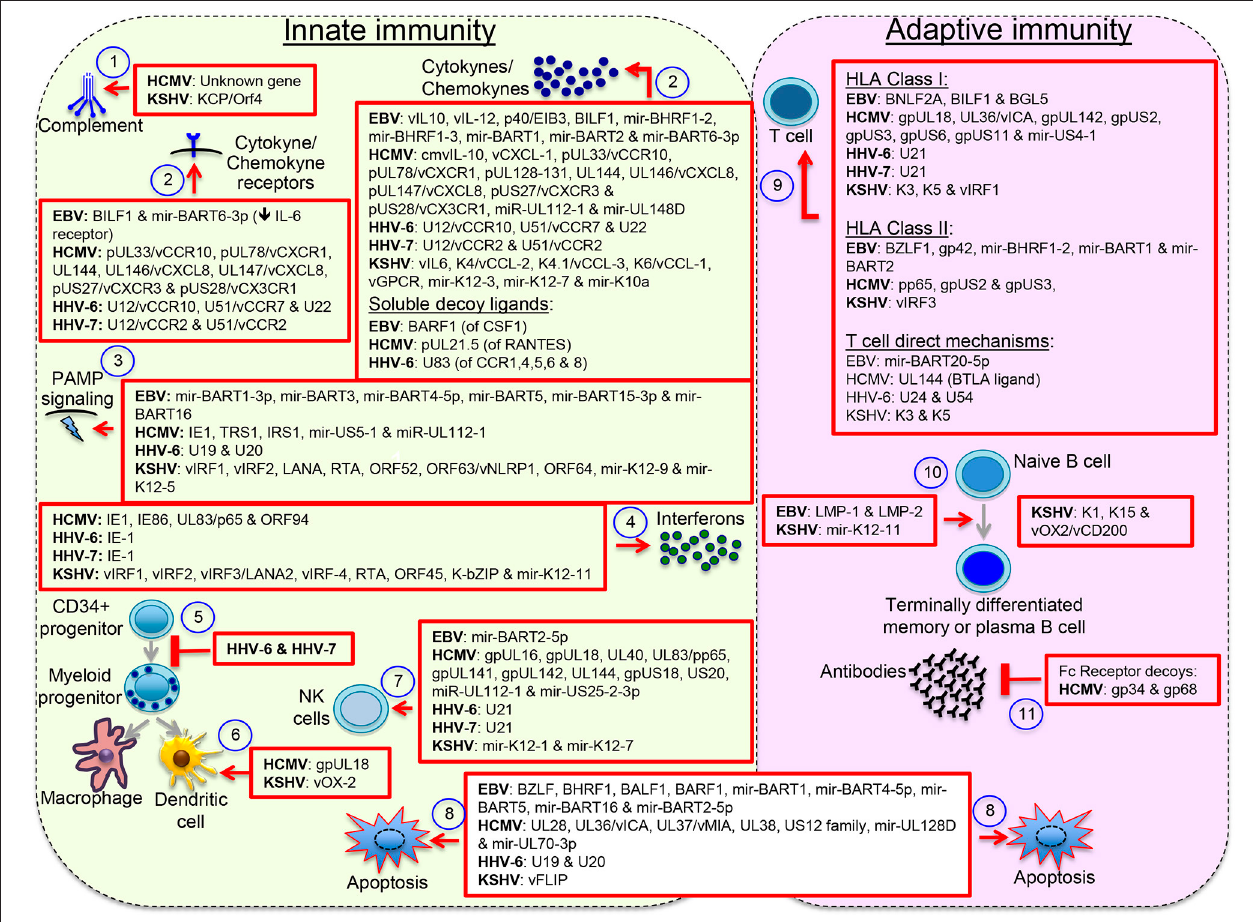
FIGURE 2 | Herpesvirus immunomodulatory mechanisms. Immunomodulatory viral genes function at multiple levels: (1) antagonizing complement, (2) interfering with host cytokines and chemokines, (3) & (4) interfering with the pathogen-associated molecular pattern (PAMP) signaling pathways that lead to interferon activation or directly with the effects of interferons, (5) inhibiting maturation of myeloid lineages, (6) interfering with the activity of terminally differentiated myeloid cells, (7) interfering with expression or function of NK cell activating and inhibitory receptors, (8) blocking intrinsic and extrinsic mechanisms of cell apoptosis, (9) interfering with activation of T cells through inhibition of peptide processing or HLA/peptide molecules surface deposition or through direct mechanisms of T cell inactivation, (10) inducing B cell differentiation into long-lasting immunoprivileged memory B cells, and (11) interfering with humoral responses though expression of Fc receptor-like molecules. Other reported mechanisms not illustrated here include formation of regulatory populations and interference with the PD1/PDL1 and other immune regulatory checkpoint proteins. Viral orthologs of human cytokines/chemokine/receptors are denoted with the letter v . This figure does not pretend to be a complete review but to illustrate the wide spectrum of immunomodulatory mechanisms displayed by